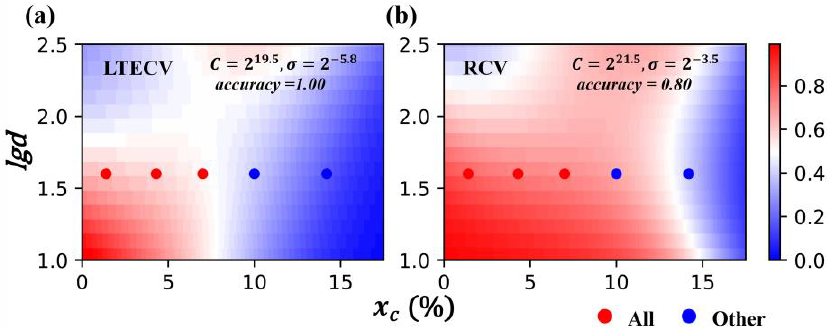
Figure 5. Comparison of the generalization ability of two CV methods. The color bar indicates the probability of generating the 1:7 H single phase, and red means it is easier to obtain the stable 1:7 H phase. Red points represent the test set, indicating the experimental data of prepared SmCo 7 − x Mn x (x = 0.1, 0.3, 0.5, 0.7, 1) bulk alloys without training in the ML process [25]. ( a ) Experimental results and prediction results from LTECV; ( b ) Experimental results and prediction results from